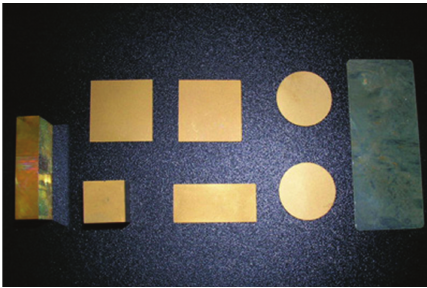
Figure 1: Typical samples of